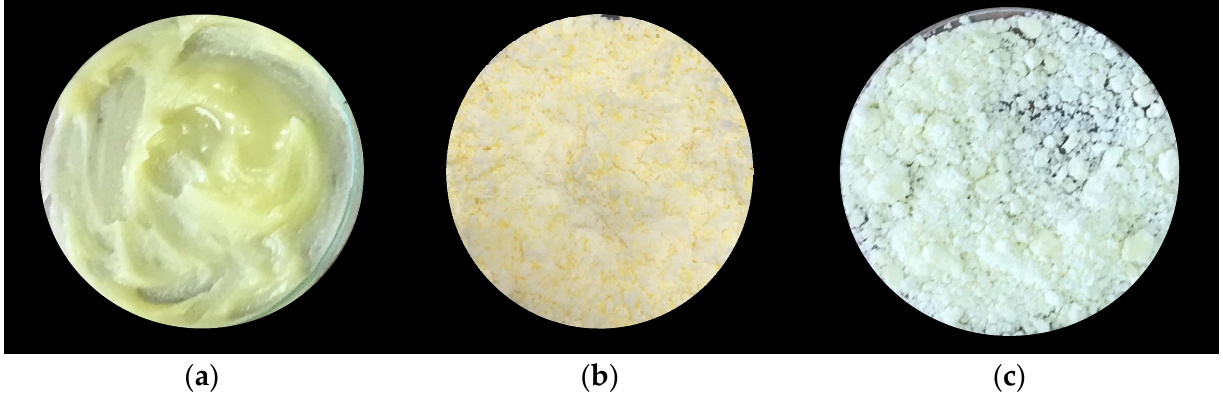
Figure 3. EVOO: α CD inclusion complexes at different ratios: ( a ) EVOO: α CD at 1:1.8 weight w : w ; ( b ) 1:2.6 w : w , and ( c ) 1:3.4 w:w .